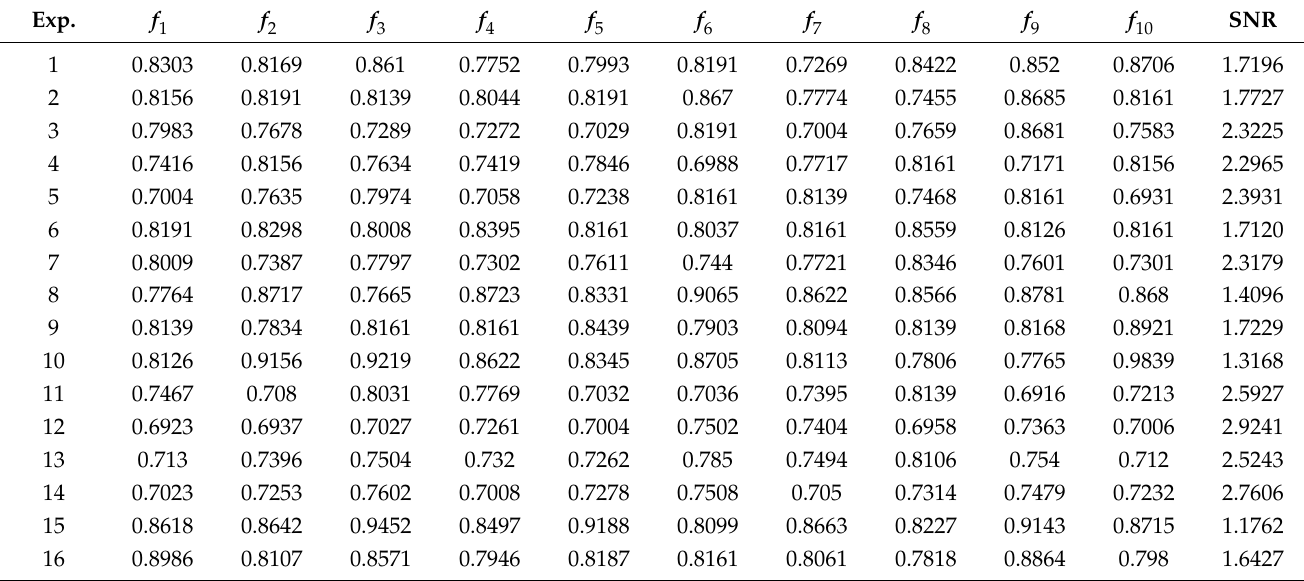
each group of experiments was run independently 10 times. The SNR of each group of experiments was obtained according to Equation (9), as shown in Table 5: Table 5. Experimental results.